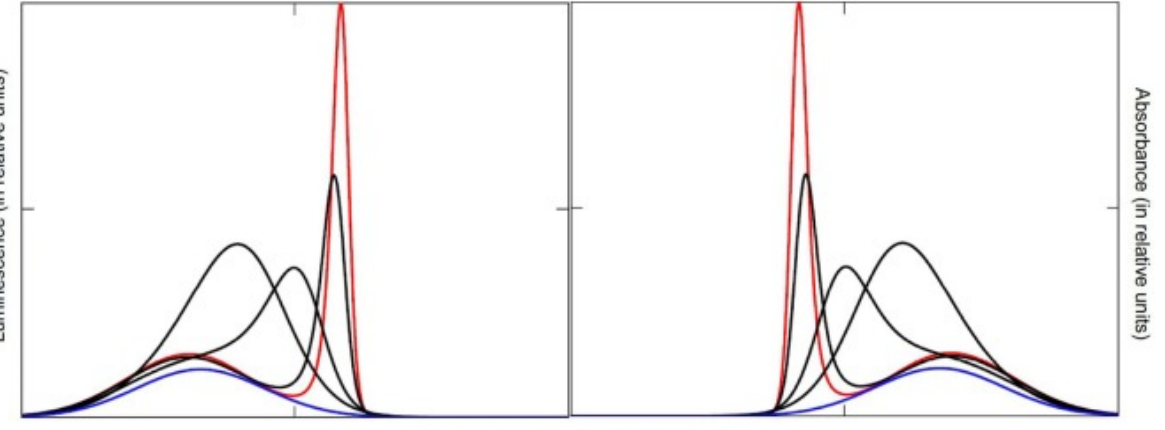
Figure 8. Symmetric picture of absorption (see Figure 1b) [7,8] and luminescence spectra obtained by changing the sign in the heat energy ∆ → − ∆ (Equation (31)) in theoretical absorption spectra (Equations (7)–(27)) [6] according to standard quantum mechanics of condensed matter [11].